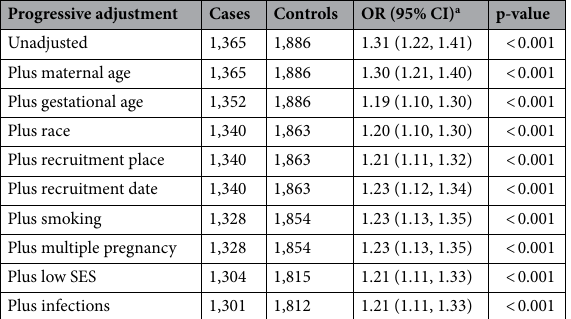
Table 2. Uric acid levels and presence of pre-eclampsia with progressive adjustment of logistic regression models. SES, Socioeconomic status. a OR indicates the change in odds of being a case for each 1 SD increase in uric acid